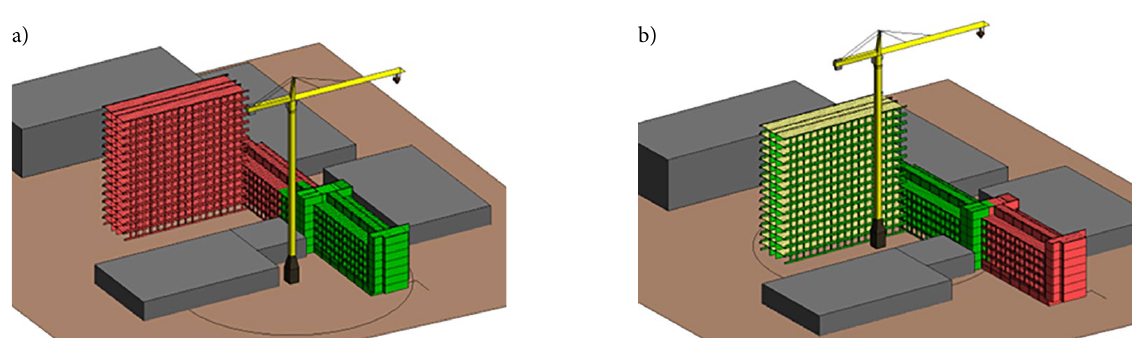
Figure 8. The algorithm for selecting the crane